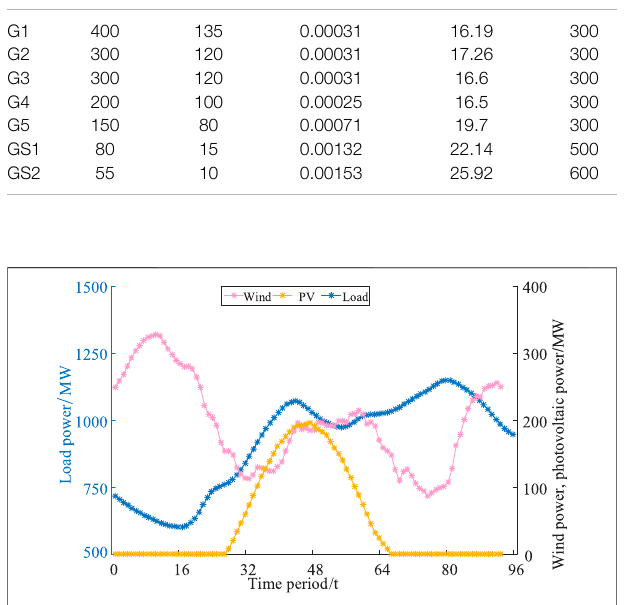
FIGURE 4 | Ultra-short-term forecast curves for wind, PV and load.